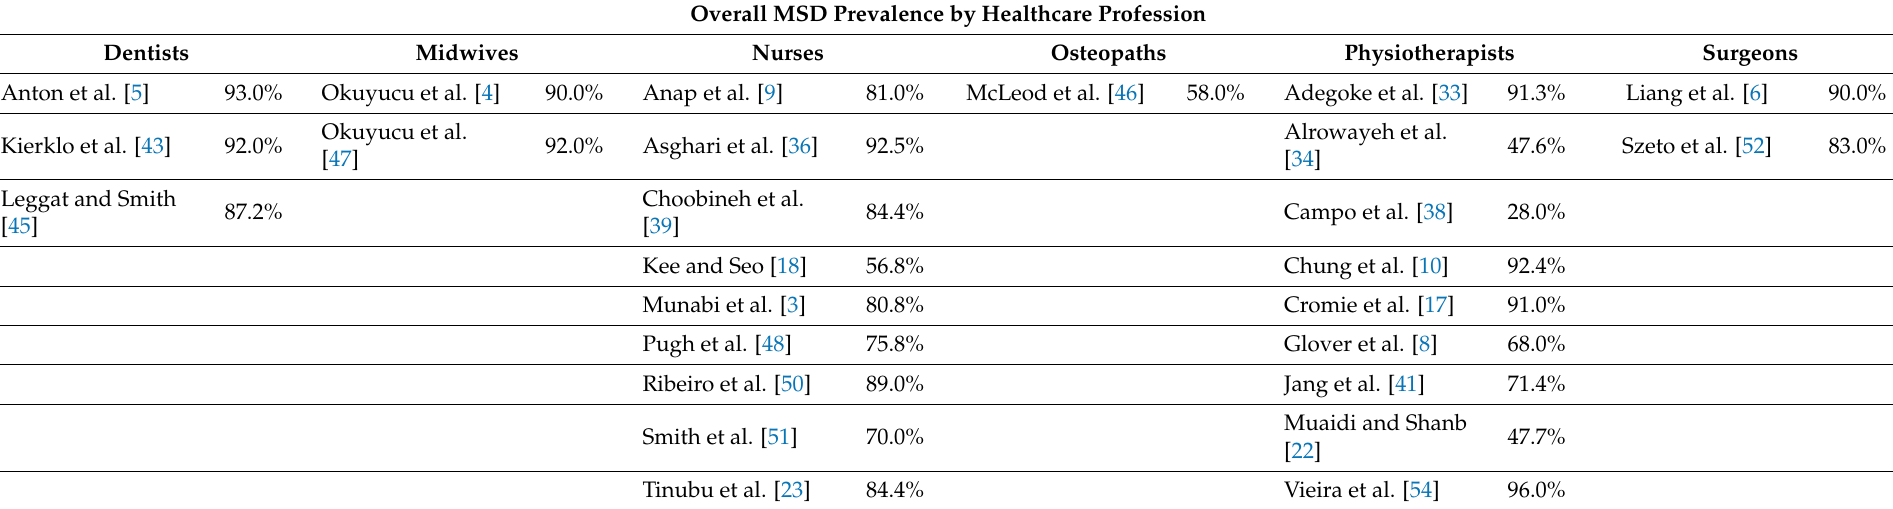
Table 3. Overall MSD prevalence by healthcare